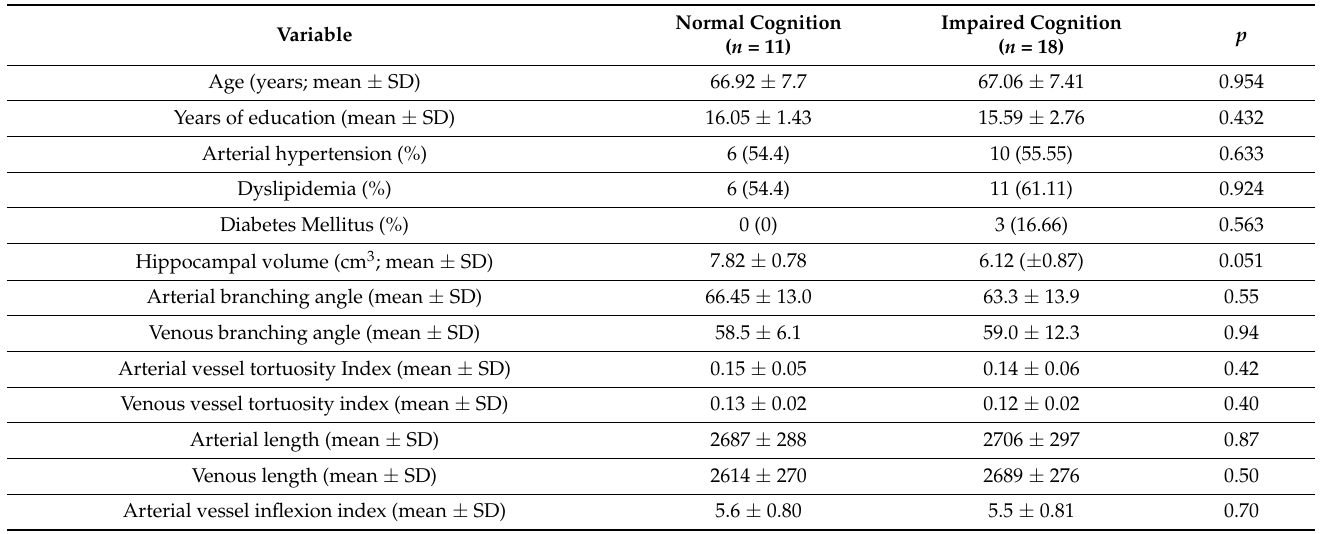
Table 2. Vascular and amyloid parameters stratified by the cognitive